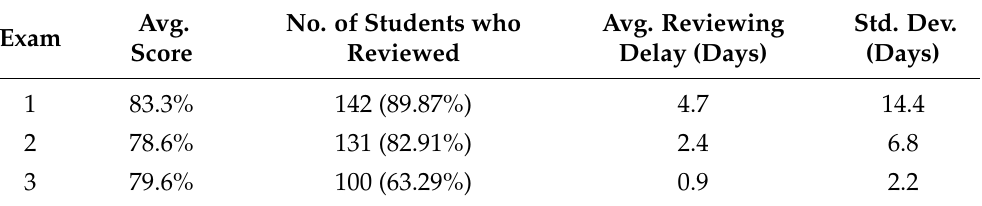
Table 2. Overview of students’ reviewing